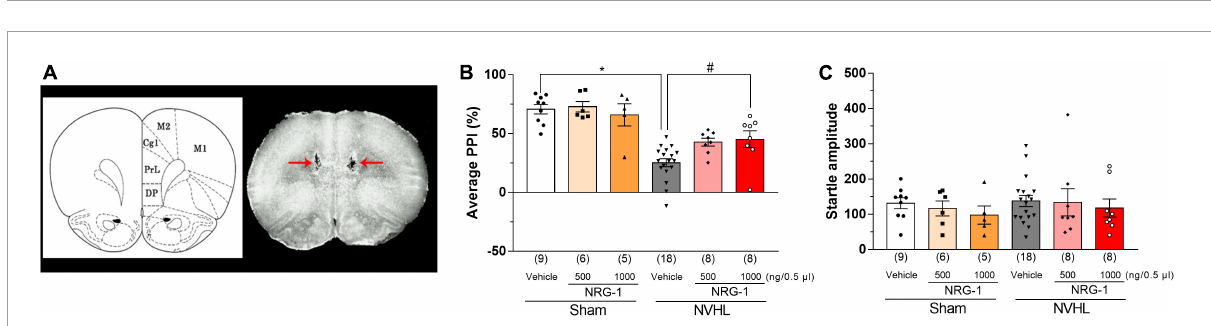
FIGURE4 Intra-cortical microinjection of NRG-1 improves NVHL-induced PPI deficits in rats. (A) Photograph of cortical microinjection sites of NRG-1. Schematic drawing of coronal brain sections and photograph of a frontal section of the brain in an animal with microinjection are shown in panel (A) . Red arrows indicate the microinjection sites of NRG-1 into the mPFC. Effect of NRG-1 on average PPI (B) and startle amplitude (C) in sham and NVHL rats. Numbers in square brackets indicate the number of animals in each group. Bars represent means ± SEM. * p < 0.05 vs. sham group. # p < 0.05 vs. NVHL